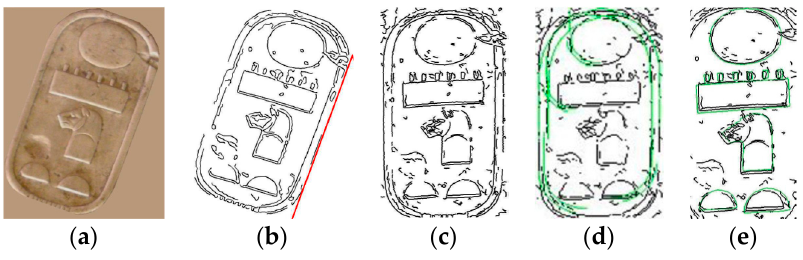
Figure 6. ( a ) Original image; ( b ) Longest border of the cartouche; ( c ) Cartouche after orientation